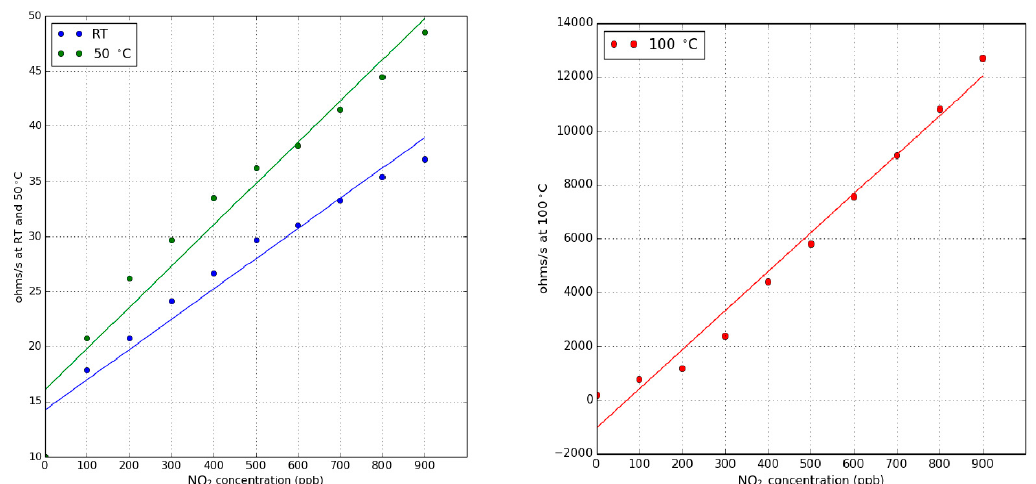
Figure 7. Calibration curves for nitrogen dioxide when the sensor is operated at room temperature, at 50 °C ( left panel ) and at 100 °C ( right panel ). The response is the rate of resistance change as defined in Equation (1). For any of the values reported in this figure, the uncertainty (variance associated to the diferent sensors tested and replicated measurements performed) remains below 15%. Reproduced